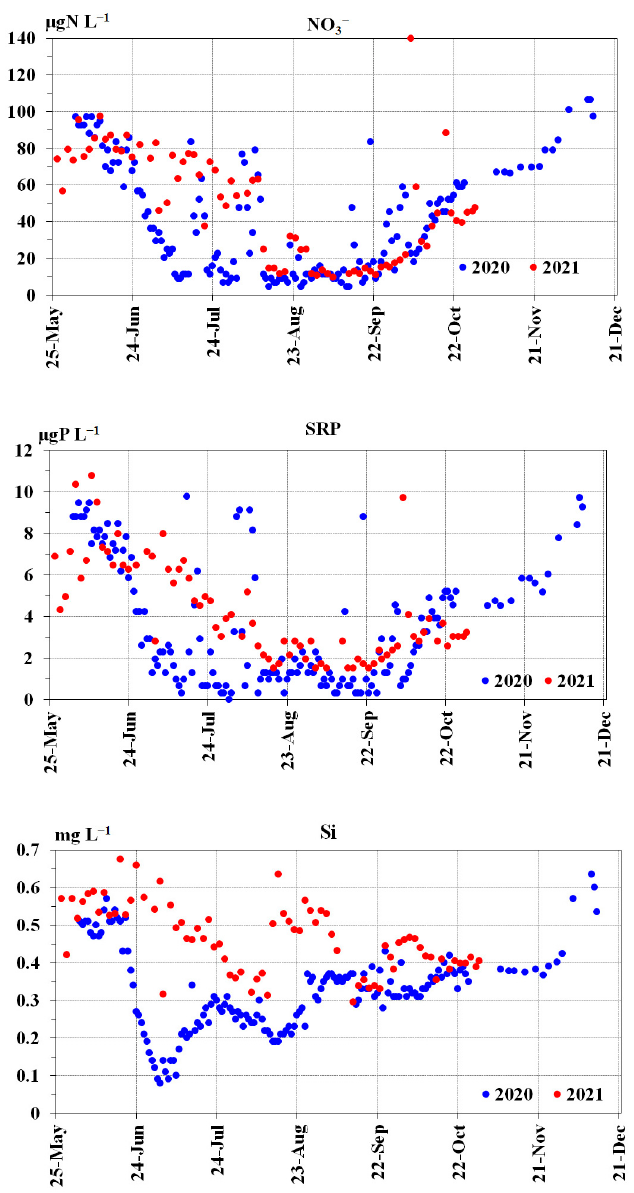
Figure 5. NO 3 − , SRP and Si concentrations in the littoral zone of Lake Baikal in 2020–2021. The main reasons for higher concentrations of nutrients in 2021 were, firstly, high water levels, and secondly, weather conditions. During the study period in 2021, according to the data of the gauging station in Baikal settlement, the fastest water rise in Lake Baikal was in June and July. The water level increased from the zero mark of the water gauge (the Baltic system of heights is 453.27 m) to 191 cm on 27 May, to 265 cm on 29 July and the water level reached 294 cm on 13 September and fluctuated between 283–290 cm until the third decade of October [51]. Wash out of the flooded area led to an increase in biogenic elements and organic matter in the littoral zone, especially on stormy days. Thus, on 6 October, the NO 3 − content increased to 140 µ g N L − 1 , SRP—to 9.8 µ g P L − 1 and total phosphorus—to 45 µ g P L − 1 . Nitrites and ammonium ions were reliably determined in the amount, respec- tively, 4 µ g N L − 1 and 13 µ g N L − 1 only in late September to early October, in the period characterized as the end of the vegetation of summer-autumn phytoplankton [19,26]. The cool and rainy summer of 2021 probably influenced the development of phytoplankton and, consequently, the decrease in consumption of biogenic